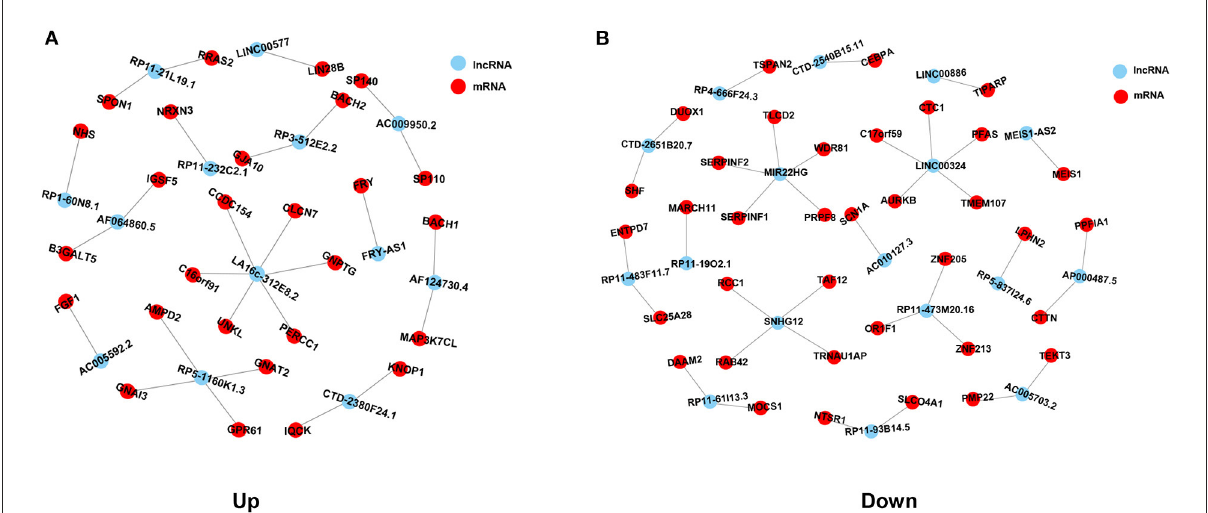
FIGURE4 Co-expression network analysis of common differentially expressed lncRNAs and mRNAs in HCM. (A) Co-expression network of upregulated common differentially expressed lncRNAs and mRNAs. (B) Co-expression network of downregulated common differentially expressed lncRNAs and mRNAs. Red spots represent lncRNAs, blue spots represent mRNAs, and lines represent the co-expression relationships between lncRNAs and mRNAs.